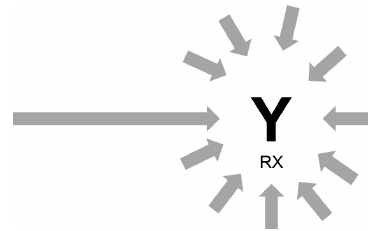
Figure 2. Illustration for the physical interpretation of Rician fad- ing: many scattered components (short arrows) are superimposed by a single dominant path (long